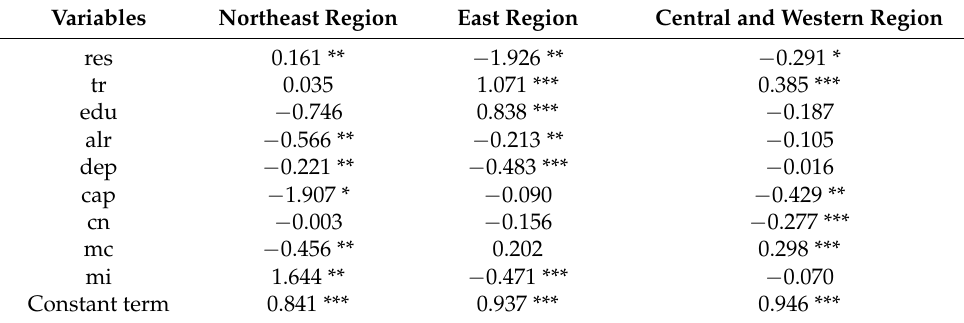
Table 5. Regression results of the Tobit model for different regions. Variables Northeast Region East